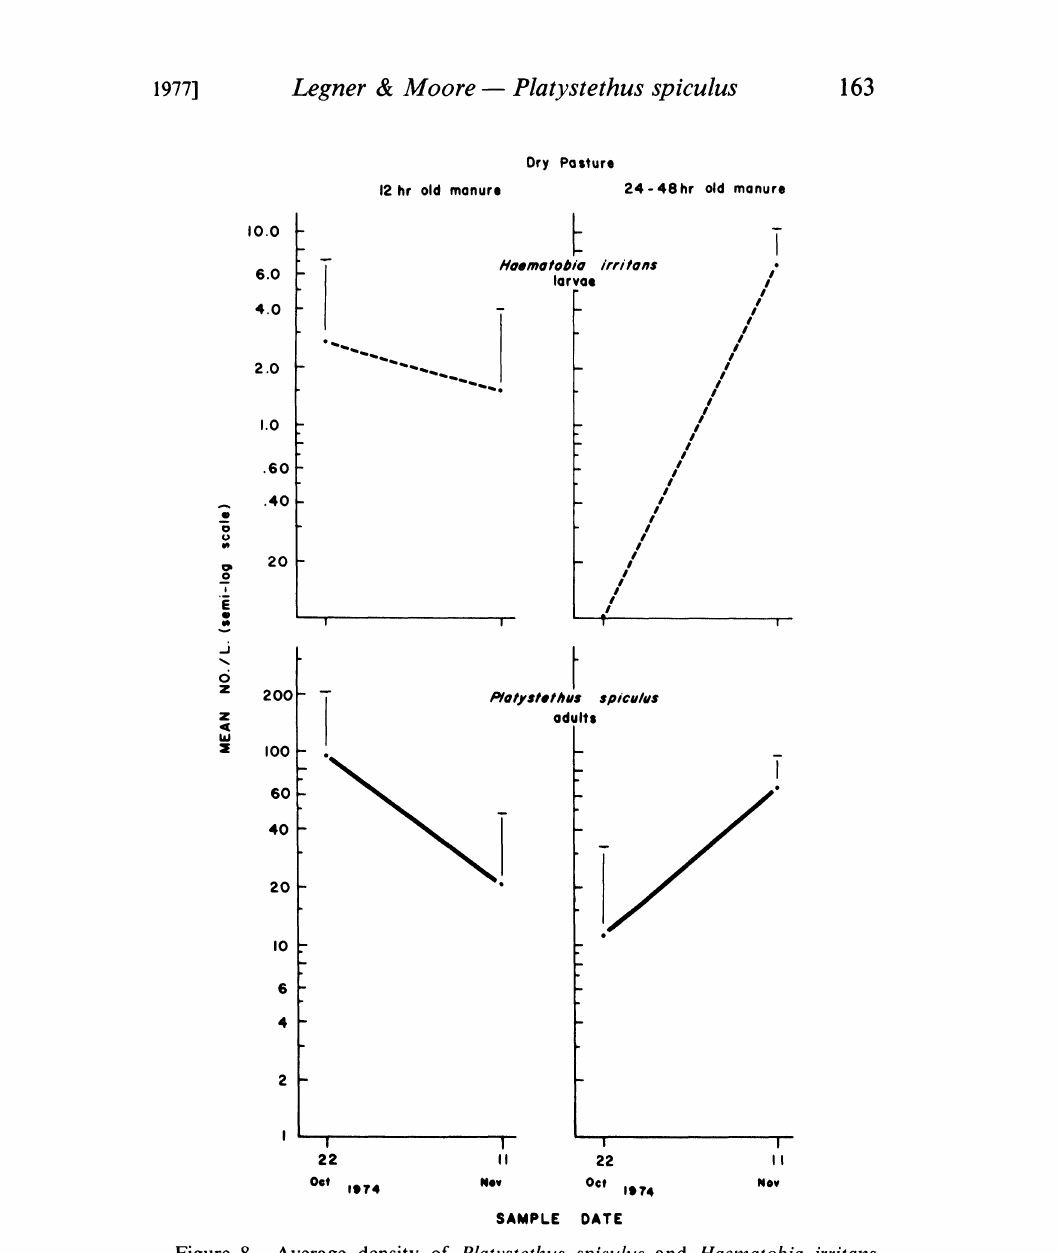
Figure 8. Average density of Platystethus spiculus and Haematobia irritans larvae, in 12- and 24-48-hr-old bovine feces from dry pastures; Calexico, California (+t 05 Conf. limit shown above each